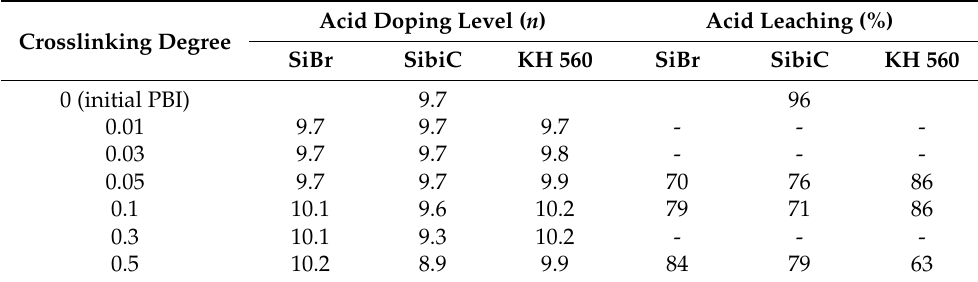
Table 2. Phosphoric acid doping level of membranes ( n ) and acid leaching (%) in relation to the silane used for crosslinking and the degree of crosslinking.